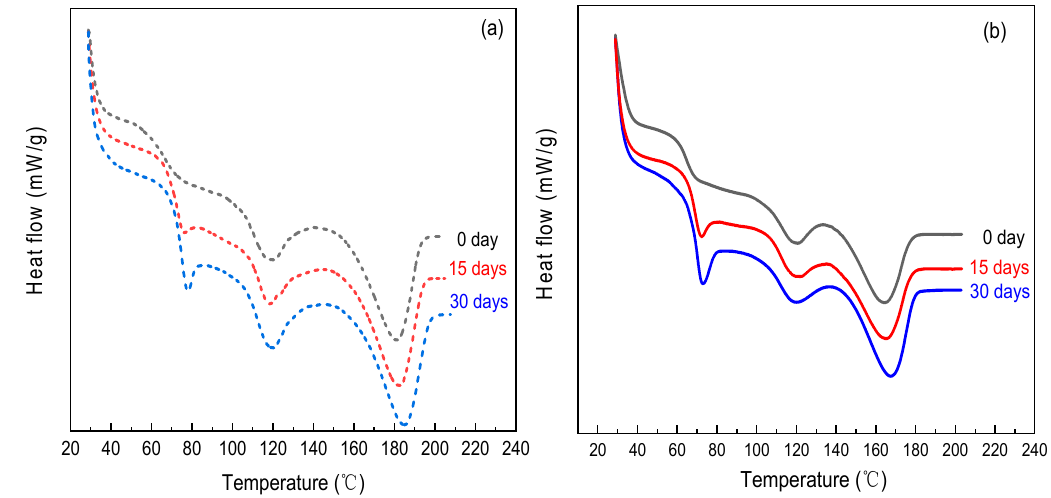
Figure 2. Effect of elapsed time on DSC thermograms of ( a ) PVA and ( b ) PVA-LiClO 4 .